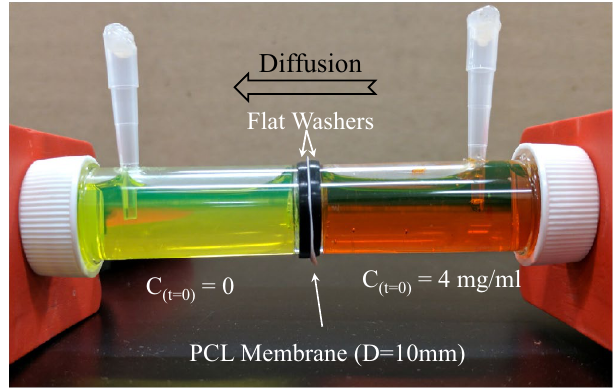
Figure 2. The experimental setup for monitoring the diffusion of the model probe, i.e. fluorescein sodium salt through the PCL